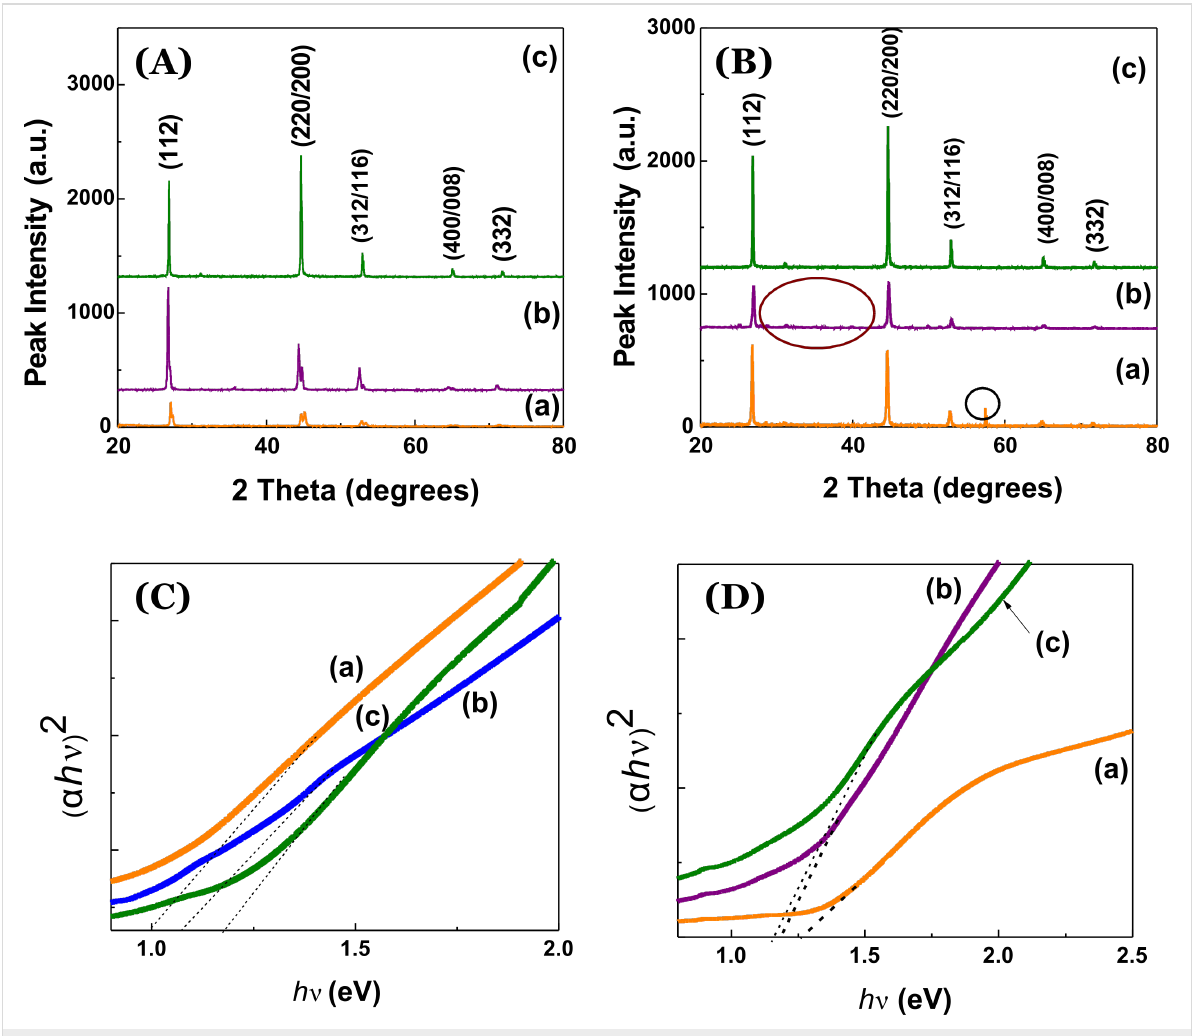
Figure 3: X-ray diffraction pattern of (A) pristine and (B) light-soaked, optical band gap determination based on Tauc’s plot, ( α h ν ) 2 vs h ν plot of (C) pristine (D) light-soaked chalcopyrite nanocrystals of (a) CISe, (b) CIGSe and (c) CZTSe.